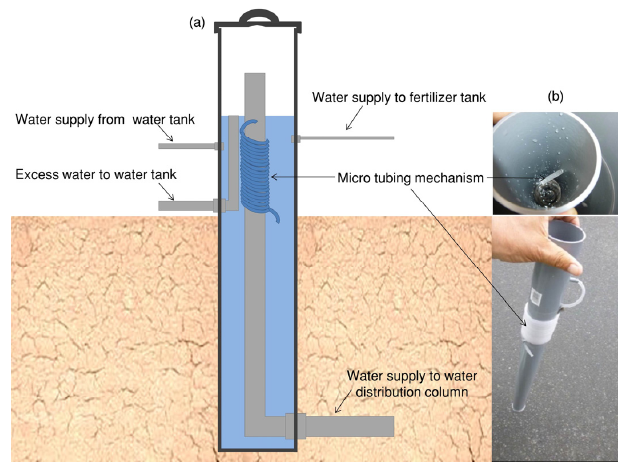
Figure 3. Water supply column ( a ) Schematic diagram of water supply column ( b ) Use of micro tubing mechanism.